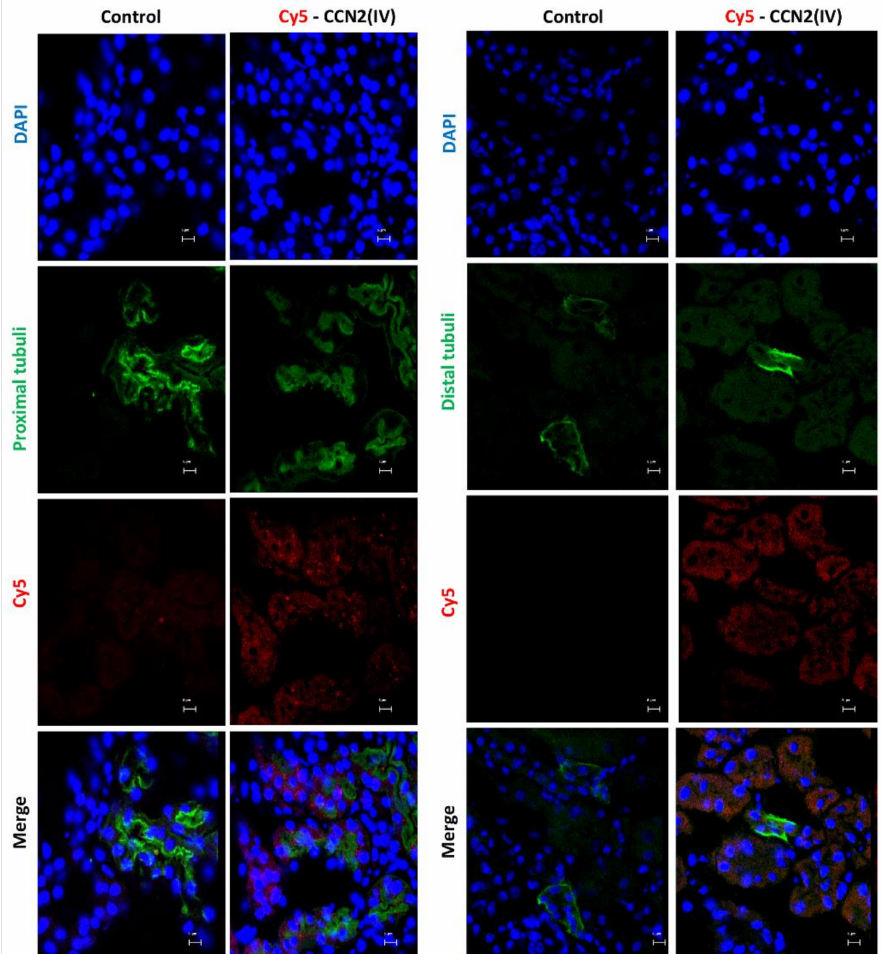
Figure 4. Determination of CCN2(IV) binding to proximal or distal tubuli in the kidney in the model of systemic administration of CCN2(IV). Co-localization of Cy5-CCN2(VI) (red) staining with markers of proximal (LotusTetragonolobus Lectin, green) or distal (Dolichos Biflorus Lectin, green) tubuli in CCN2(IV)-injected mice. Proximal tubuli are the main sites of Cy5-CCN2 binding sites. The scale bar represents 5 µ